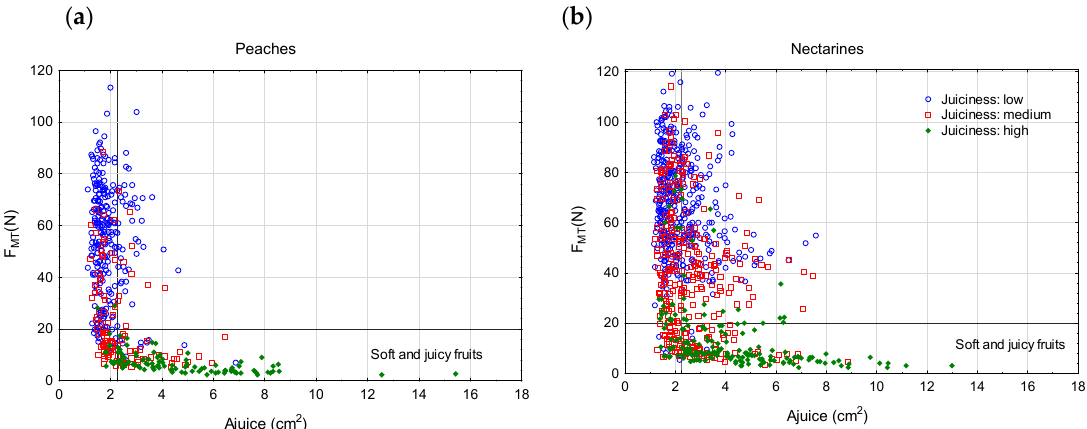
Figure 1. Scatterplot of instrumental juiciness (Ajuice (cm 2 )) of fruit (season 2018) vs. instrumental firmness (F MT (N)), categorized according to the category of sensory juiciness belonging to ( a ) peaches and ( b ) nectarines. The black lines indicate the limits of firmness and instrumental juiciness (10th percentile) that delimit the instrumentally identified fruits as soft and juicy.